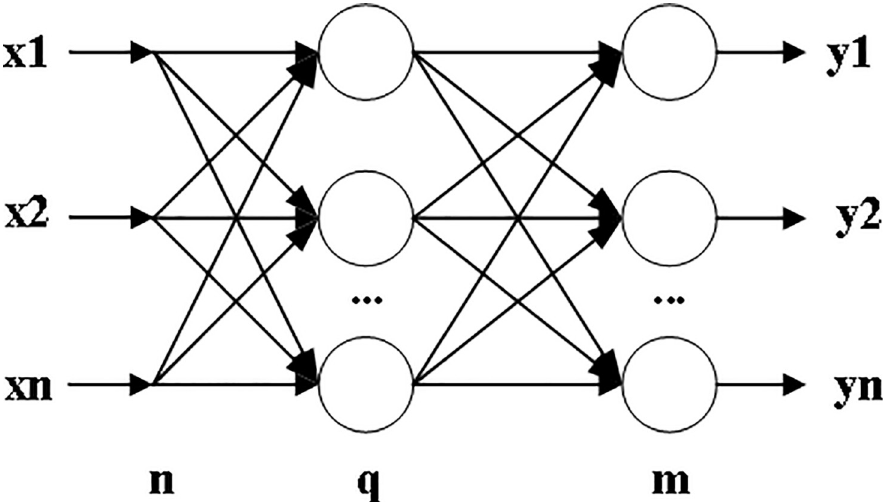
Fig 5. Topology of a three-layered neural